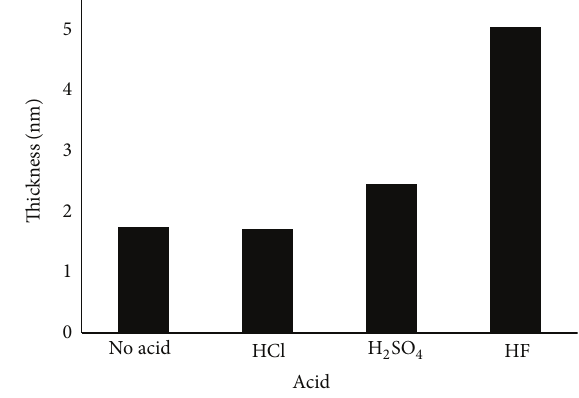
Figure 7: Effect of inorganic acids on thickness of Au thin films. Galvanic displacement is conducted in 1.0mM, HAuCl 4 solution containing plating bath which includes 0.8 M HCl, 4.6M H 2 SO 4 , or 3.3 M HF for 3